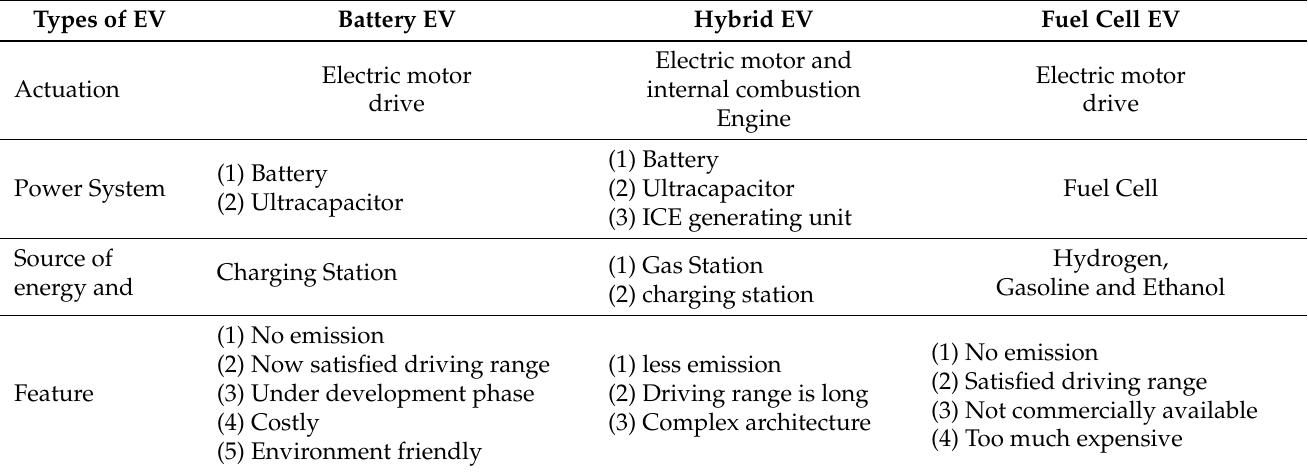
Table 1. Summary of BEV, HEV and